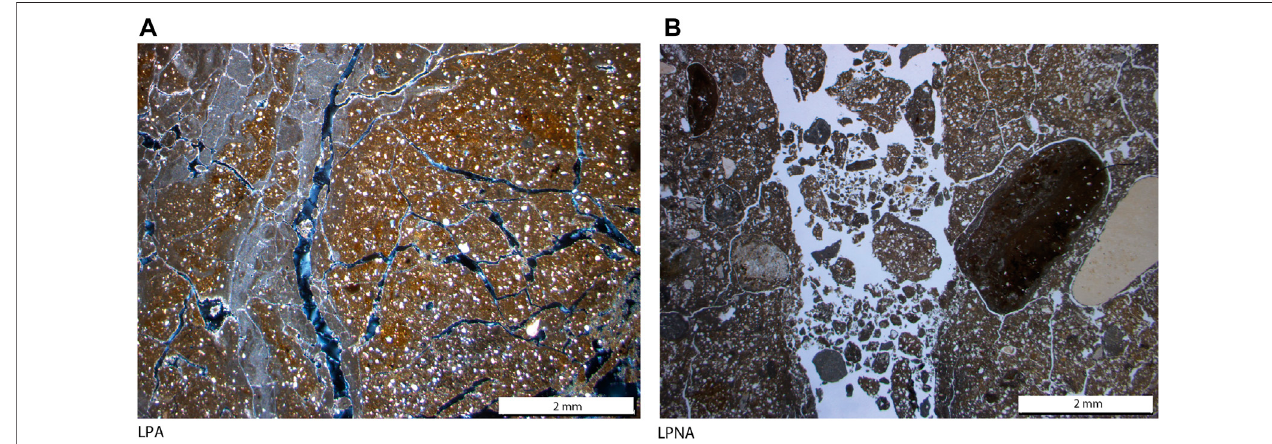
FIGURE 7 | Cracking of deposits including (A) partially or completely fi lled cracks with very fi ne sand (sample KH 5B, layer IV) and (B) deposition by illuviation or heterogeneous aggregates (sample KH 4B, layer IV).